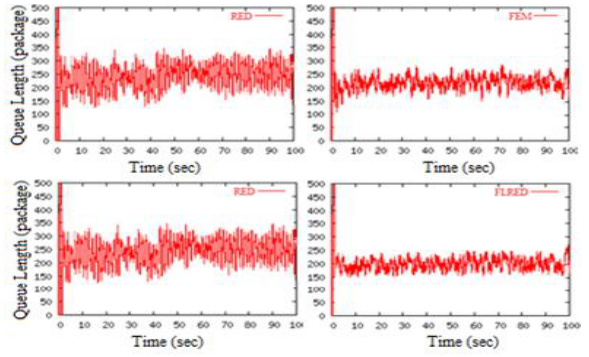
Figure 7. Control the queue of RED, FEM and FLRED When the simulation REM mechanism and the mechanisms to improve REM have used fuzzy controller (FUZREM, FLREM), results in Figure 8, shows that the mechanism controlling REM queue is unstable, whereas the FUZREM and FLREM mechanisms keep the immediate queue length at network nodes is relatively stable. However, due FLREM nine bell membership function as fuzzy input values so be increased precision makes it possible queue stability better than FUZREM.